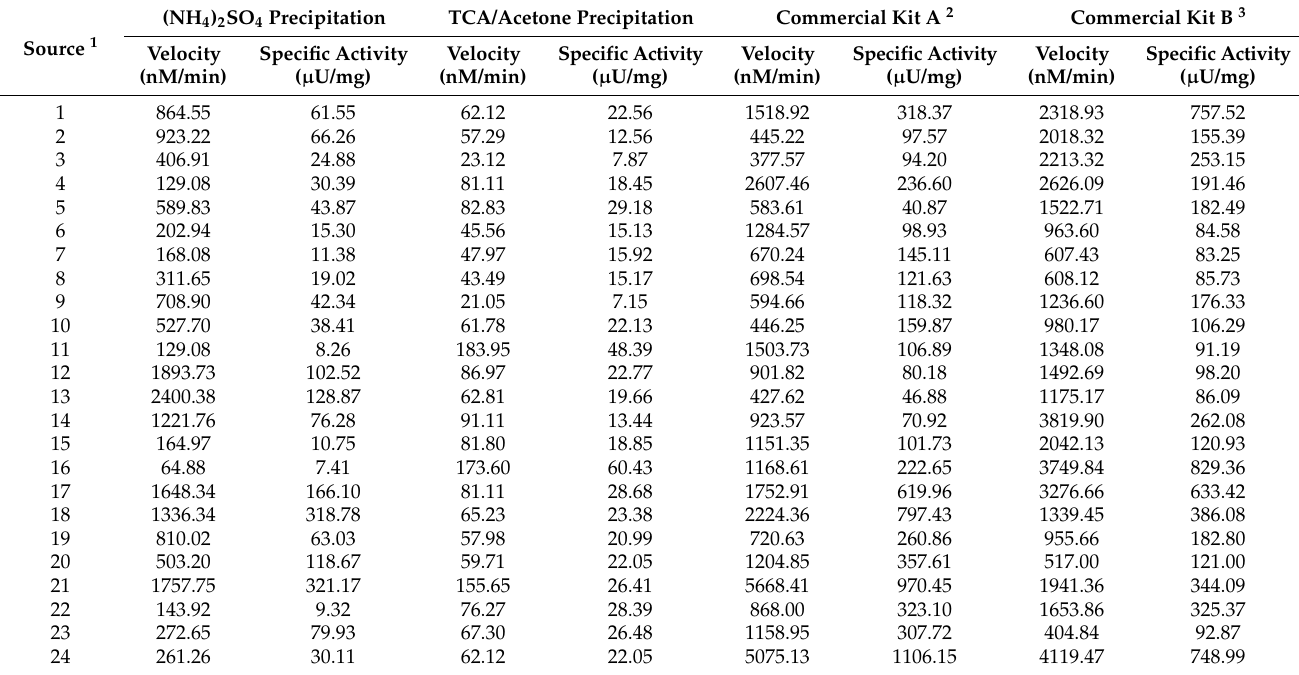
Table 2. Specific activity of crude protein extracts from 24 domestic agricultural products (spectrophotometric assay).